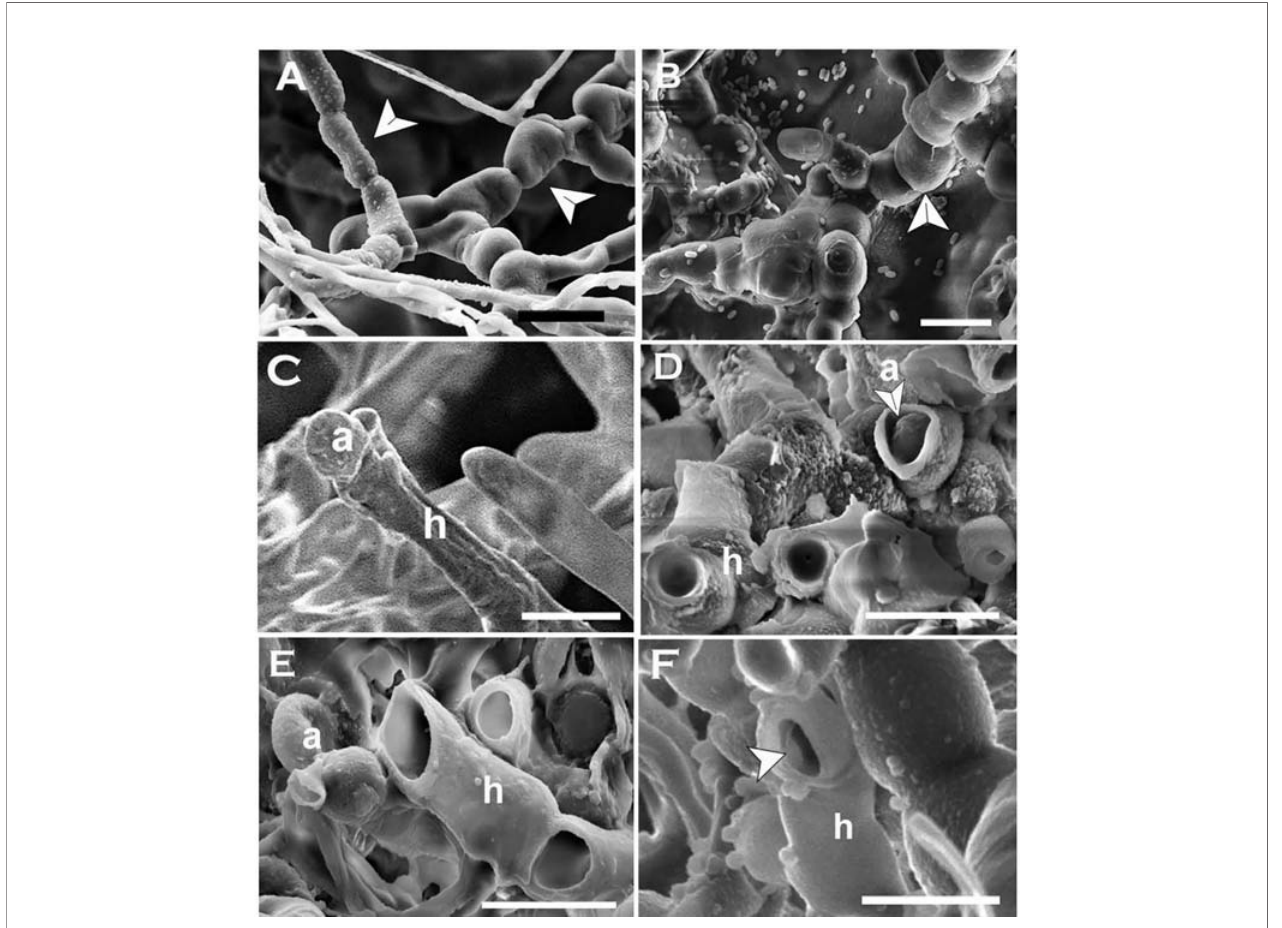
FIGURE 9 | Formation and release of arthrospores (arthroconidia) produced in-vitro from Neopseudocercosporella capsellae hyphae as seen under the scanning electron microscope. (A, B) Series of delicately attached arthrospores (arrows) produced by 7 week old colonies of isolate UWA Wlj-3 on NDY (A) and PDA (B) . The arthrospores break off and disseminate when disturbed (Scale bars = 5µm). (C, D) Releasing spherical arthrospore (a) after transverse dehiscence of the hyphae (h) at the septa. (D, F) Hyphal cell walls after releasing arthrospores by dehiscence along the septa (C) or centripetal dehiscence (D) (Scale bars =